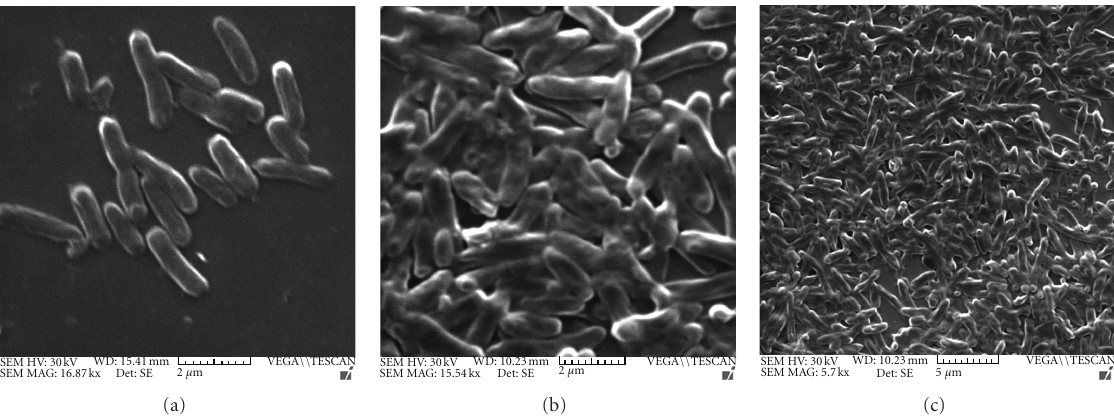
Figure 8: Scanning electron microscopy images showing adherence and biofilm formation on glass. (a) E. coli DH5 α -pGEM cells adhering to abiotic (glass) surface. (b), (c) E. coli DH5 α -pGEpmt cells adhering together and forming biofilm on glass surface. (Bars and magnification indicated below representative